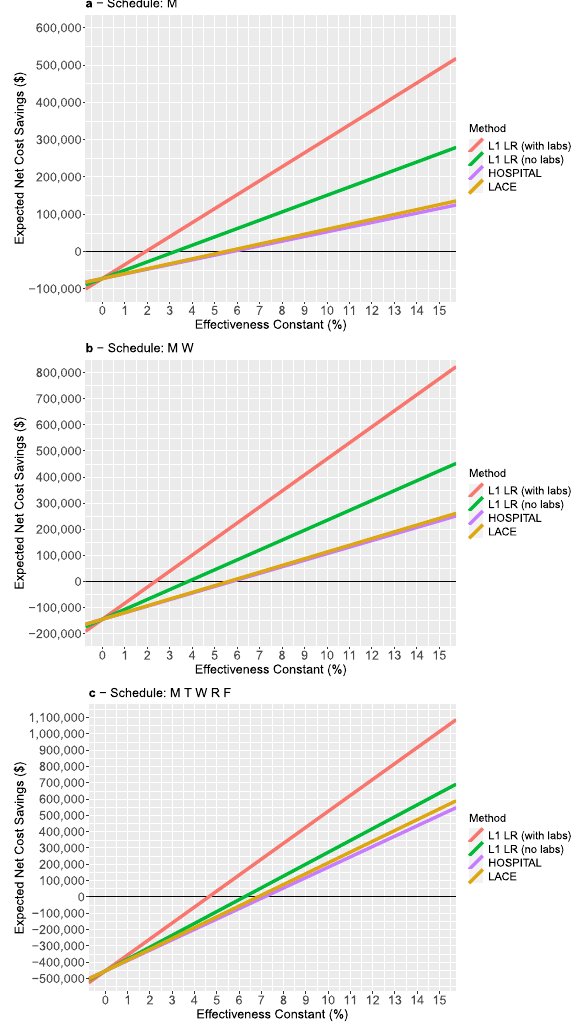
Fig. 1 Expected net cost savings as a function of the effectiveness constant, for the three different schedules. Under “ Method ” , “ L1LR ” denotes L1 regularized logistic regression. “ Schedule ” indicates the days of the week on which the provider works (M = Monday, T = Tuesday, W = Wednesday, R = Thursday, F = Friday). Panel a corresponds to a Monday-only schedule, panel b corresponds to